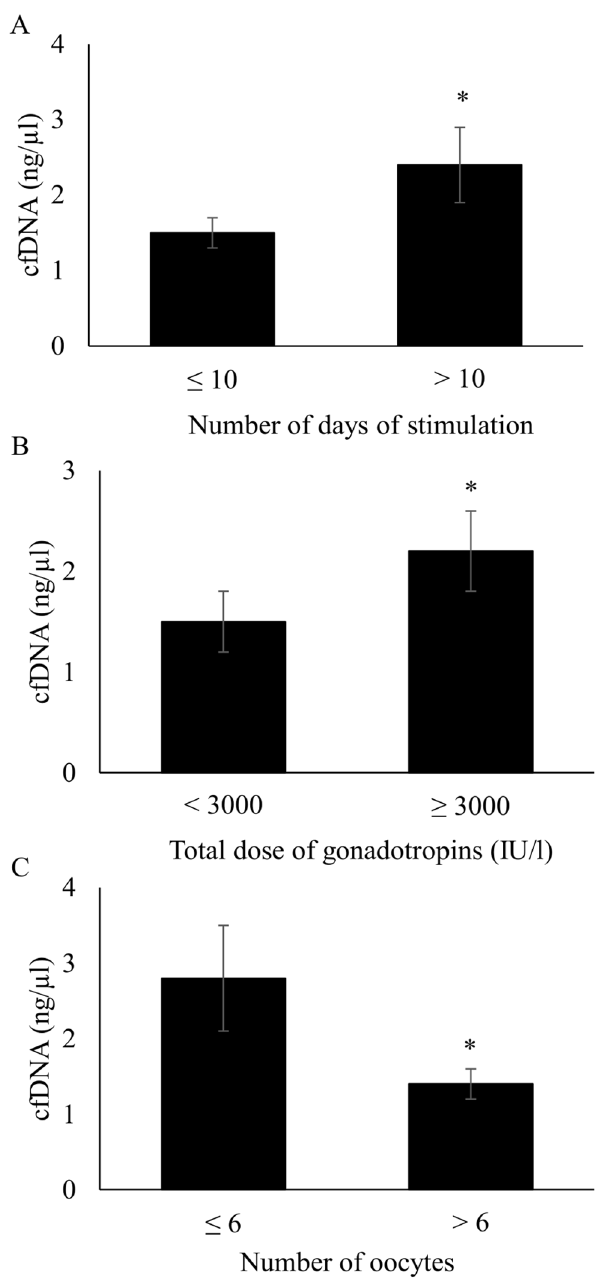
Fig 2. CfDNA level in follicular fluid pools according to the ovarian stimulation protocol and ovarian response. A , Follicular fluid cfDNA content according to the length of ovarian stimulation ( (cid:3) 10 versus > 10 days, * p = 0.008). B , Follicular fluid cfDNA content according to the total dose of gonadotropins ( < 3000 versus (cid:1) 3000 IU/l, * p = 0.01). C , Follicular fluid cfDNA content according to the number of retrieved oocytes ( (cid:3) 6 versus > 6 oocytes, * p =